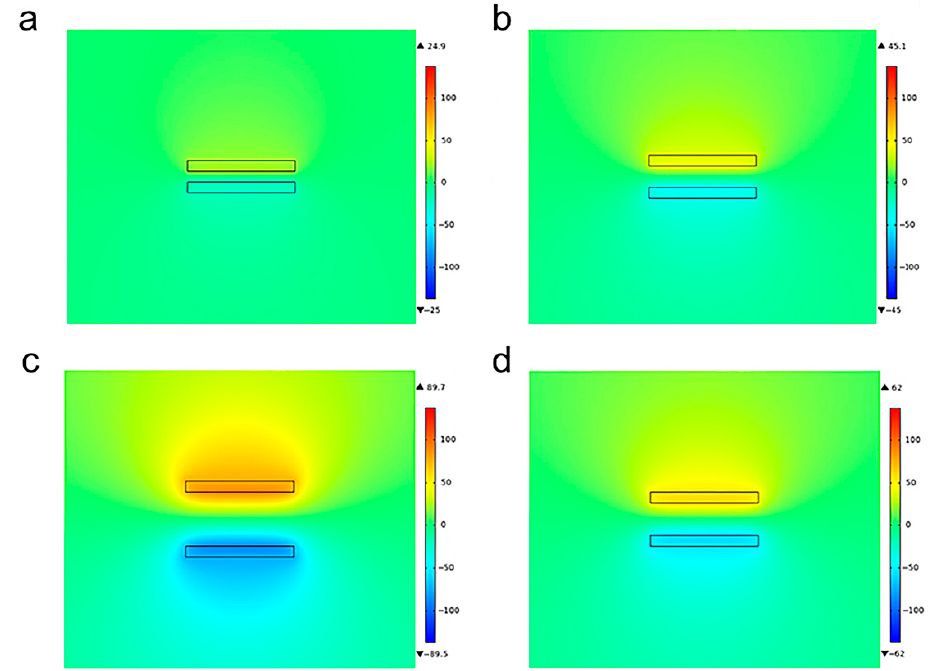
Figure 5. COMSOL Multiphysics simulation results for the S-TENGs at different states. ( a ) Early stage after separation. ( b ) Middle stage after separation. ( c ) Final stage of separation. ( d ) Recovery stage.